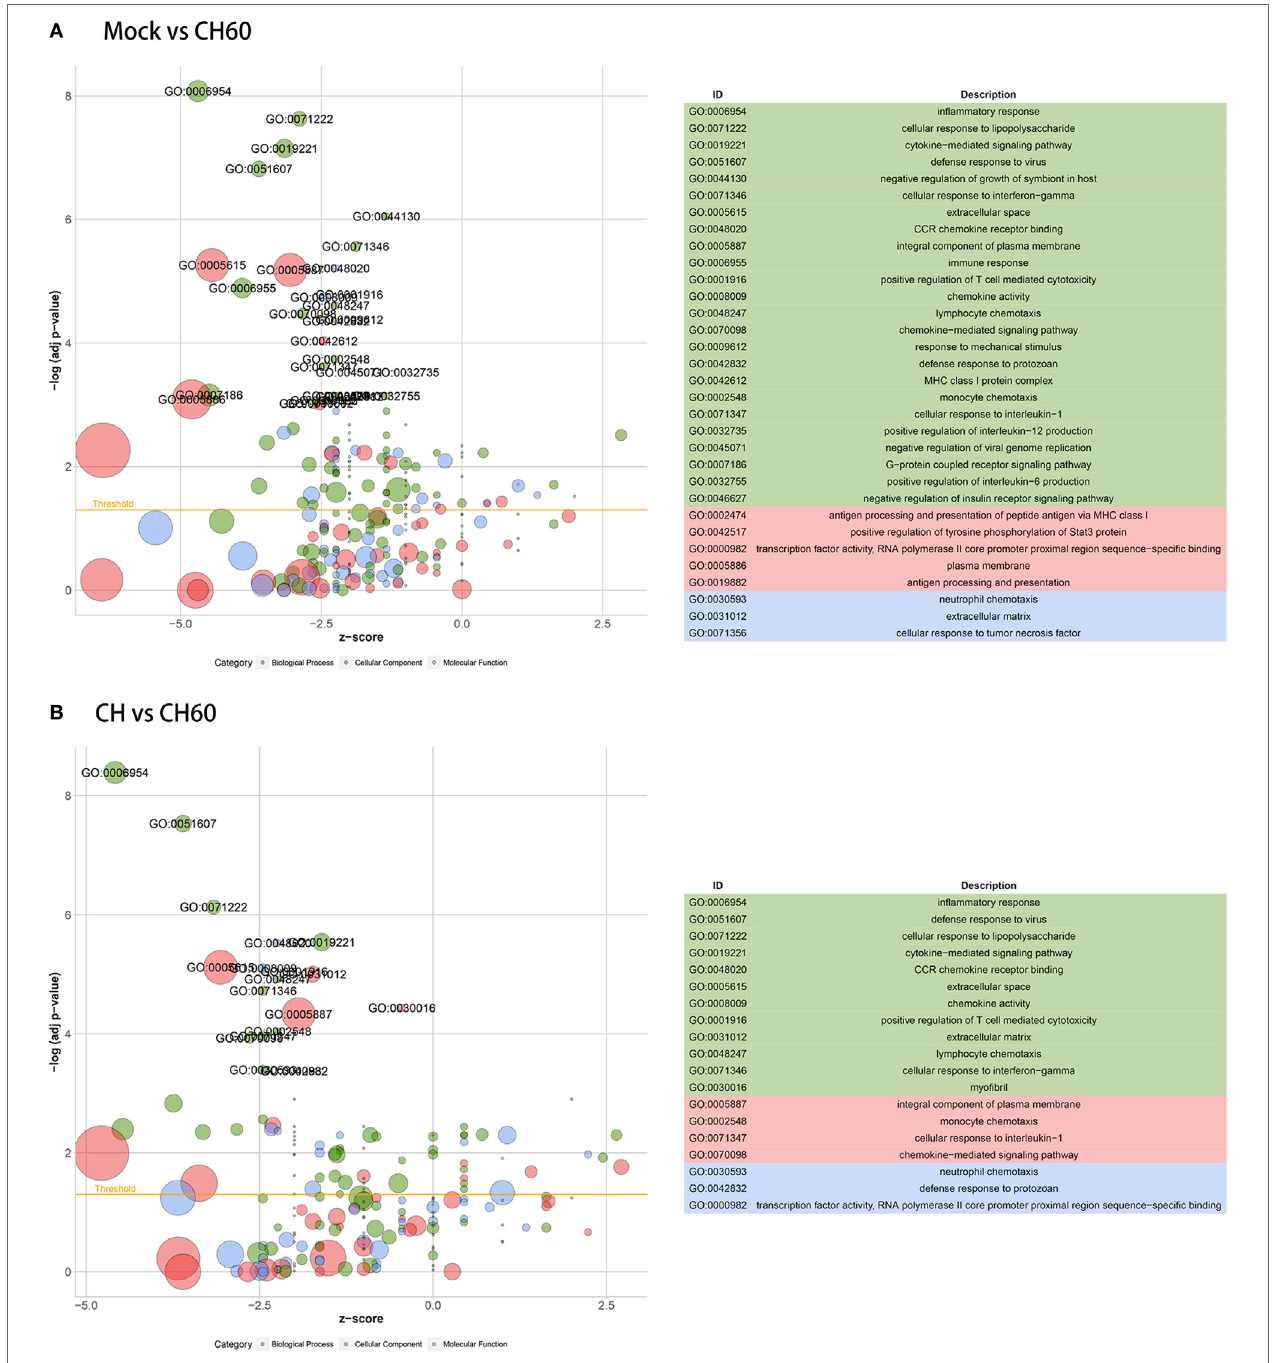
FigUre 5 | Gene ontology (GO) enrichment analysis of differentially expressed genes (DEGs). The z -score is assigned to the x -axis, and the negative logarithm of the adjusted p -value is assigned to the y -axis. The areas of the displayed circles are proportional to the number of genes assigned to the term, and the colors correspond to the categories. (a) GO enrichment analysis of DEGs between the mock group and CH60 group ( p -value < 0.01 and fold change > 4). (B) GO enrichment analysis of DEGs between the CH group and CH60 group ( p -value < 0.01 and fold change > 4).